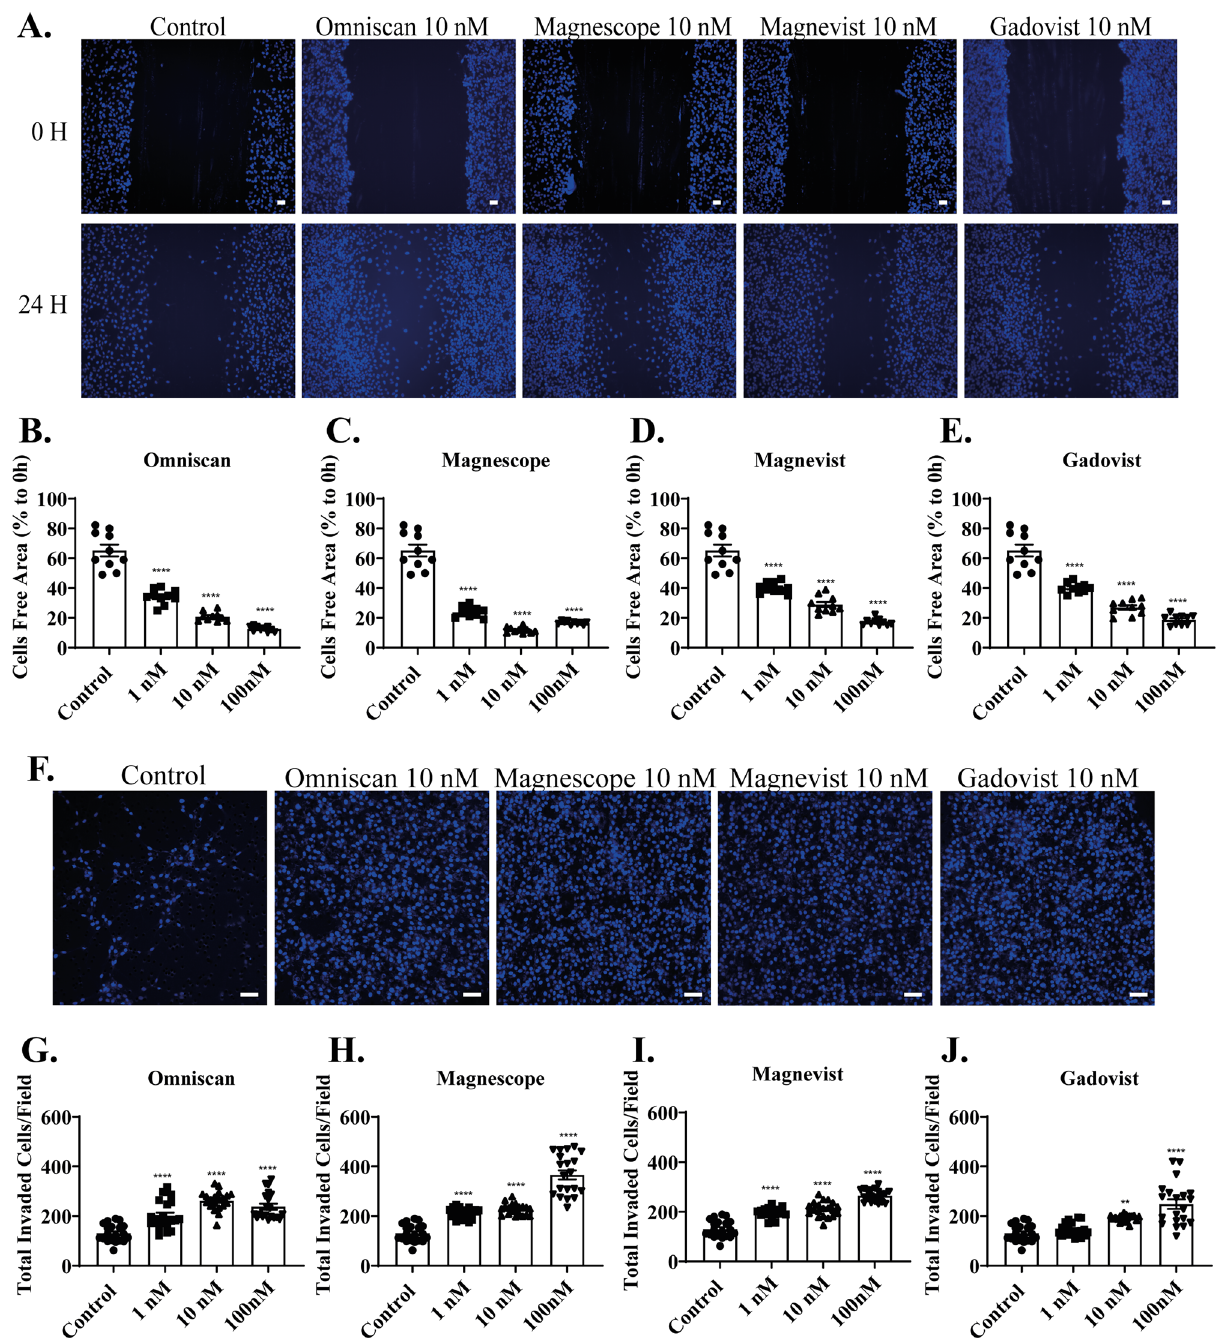
Figure 2. GBCAs accelerated astrocyte migration. ( A ) Representative photomicrographs showing the effects of GBCAs on 2D wound healing assays using C6 cells. Live-cell staining was performed using Cellstain-Hoechst 33,258 (Dojindo Molecular Technologies, Inc., Japan). Quantitative analysis of the effect of Omniscan ( B ), Magnescope ( C ), Magnevist ( D ), and Gadovist ( E ) (1–100 nM) on cell migration measured by wound healing assay. ( F ) Representative photomicrographs showing the effects of GBCAs on 3D matrigel invasion assays using astrocytes. Cell nuclei were stained with DAPI. Quantitative analysis of the effect of Omniscan ( G ), Magnescope ( H ), Magnevist ( I ), and Gadovist ( J ) (1–100 nM) on cell invasion was performed by matrigel invasion assay. The total number of cells was quantified using ImageJ software (NIH). Bars represent 50 μm. Data are expressed as the mean ± SEM of at least three independent experiments. **** p < 0.0001, ** p < 0.01, indicates statistical significance were analysed by ANOVA continued with post hoc Bonferroni’s or Turkey test compared with the